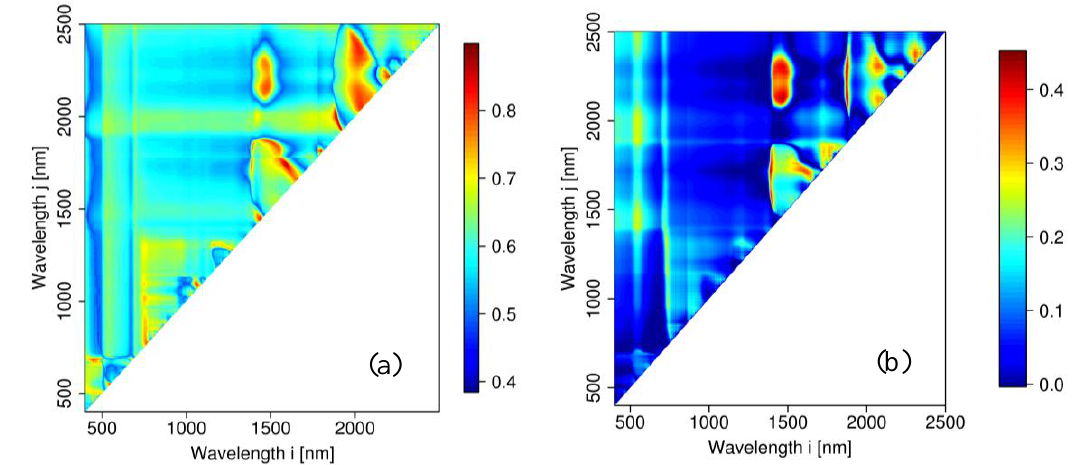
Figure 5. (a) c-Values representing the discriminatory performance of all possible two spectral ratio indices throughout the full spectral region (extracted from [29]). Logistic regression was used for binary classification of scab-inoculated and control leaves. (b) Determination coefficients of linear models fitted through protein content and all possible two spectral ratio indices. Data taken from